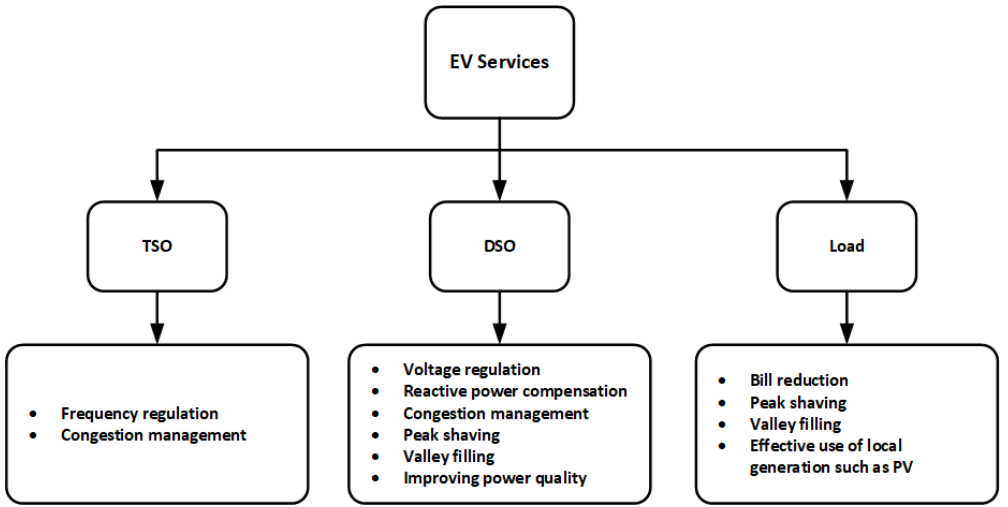
Figure 9. EV services provided to different power system parties .